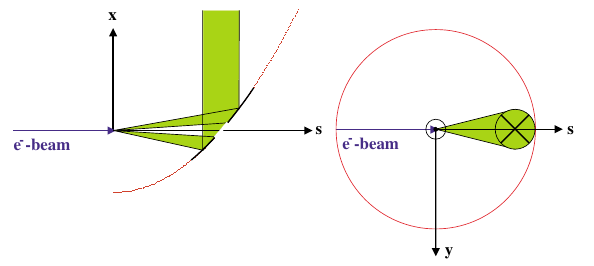
FIG. 13. (Color) Shape of the parabolic mirror and the laser focusing.